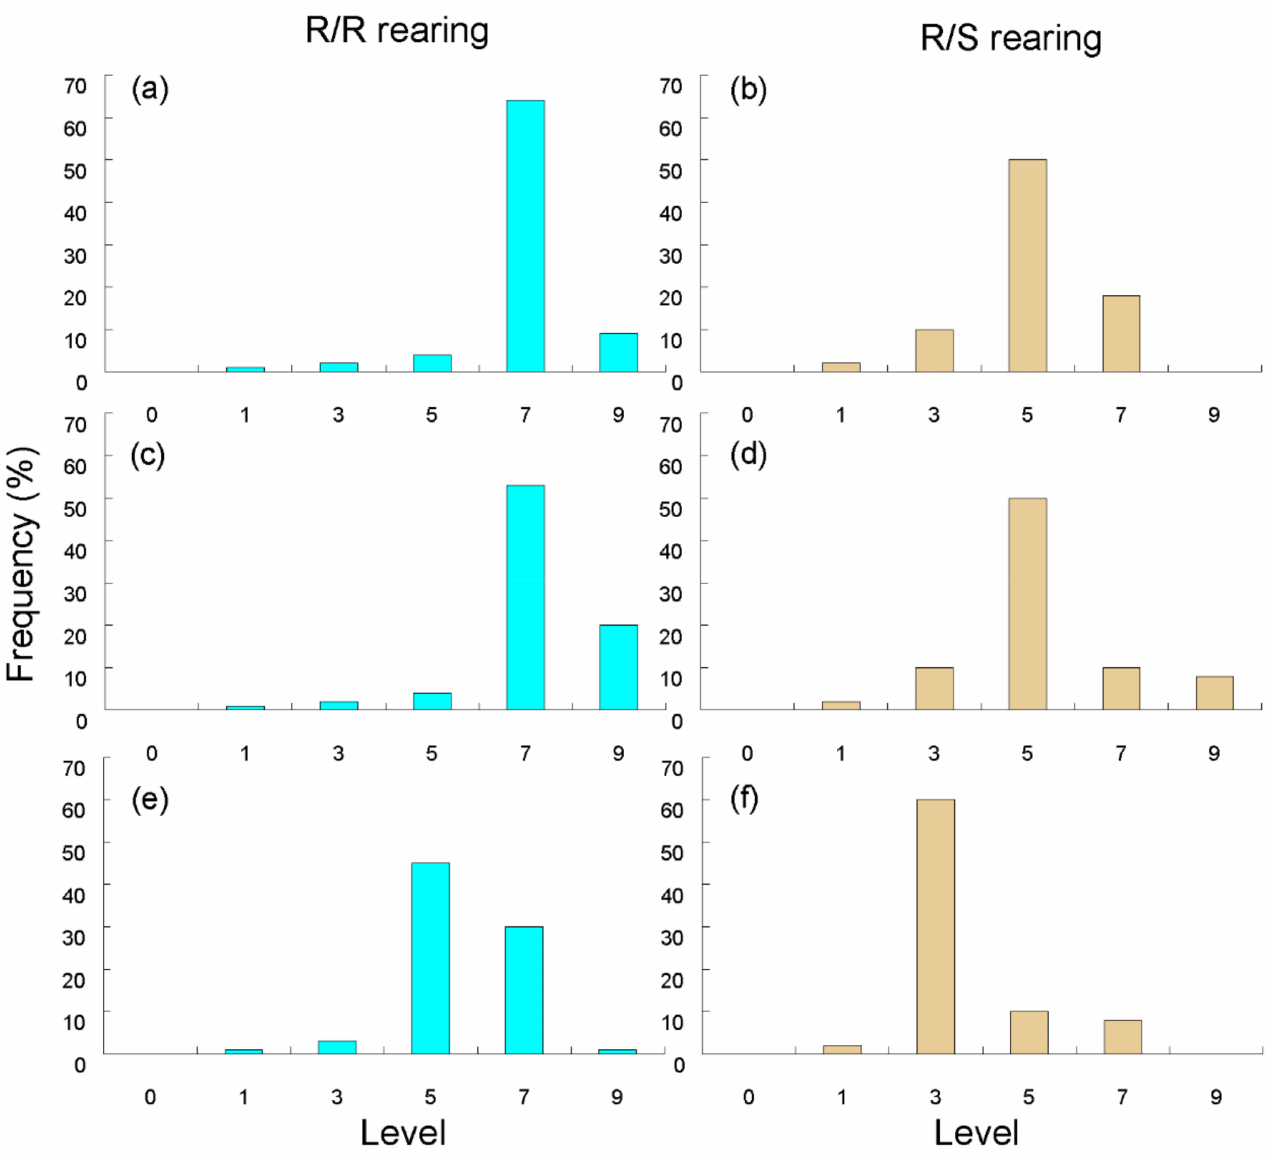
Figure 2. Frequency distribution of the resistance level of BPH acclimated to resistant/resistant and resistant/susceptible alternate rearing for 5 generations in the seedling bulk test. ( a ) Virulent to ASD7 in ASD7/ASD7 rearing; ( b ) Virulent to ASD7 in ASD7/TN1 alternately rearing; ( c ) Virulent to Mudgo in Mudgo/Mudgo rearing; ( d ) Virulent to Mudgo in Mudgo/TN1 alternate rearing; ( e ) Virulent to Rathu Heenati in Rathu Heenati/Rathu Heenati rearing; ( f ) Virulent to Rathu Heenati in Rathu Heenati/TN1 alternate